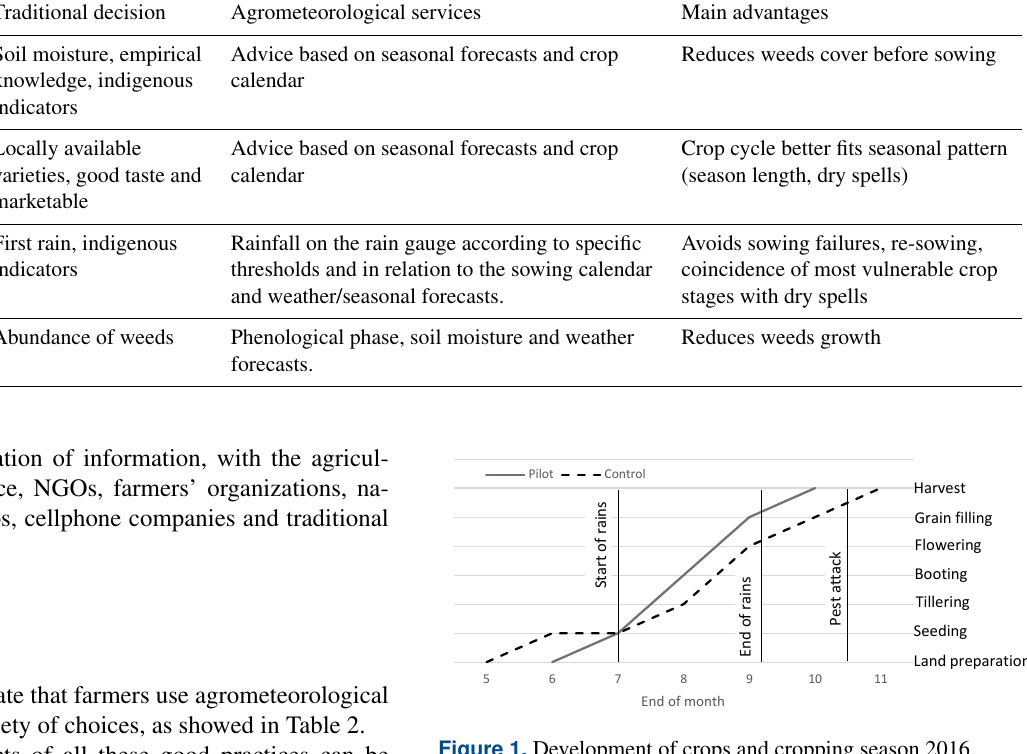
Figure 1. Development of crops and cropping season